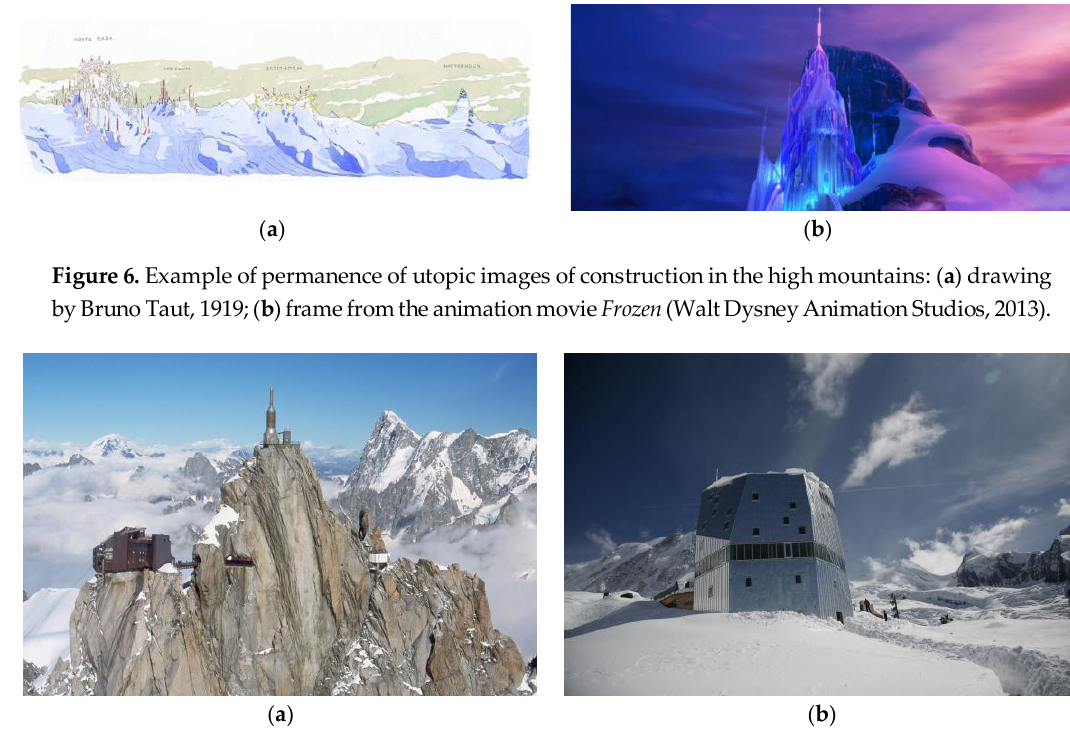
Figure 7. Remarkable examples of constructions in the high Alps, that deeply change the image of the landscape: ( a ) The highest station of the cableway of Aiguille du Midi, France, 1955; ( b ) The new Monte Rosa Hut, Switzerland,